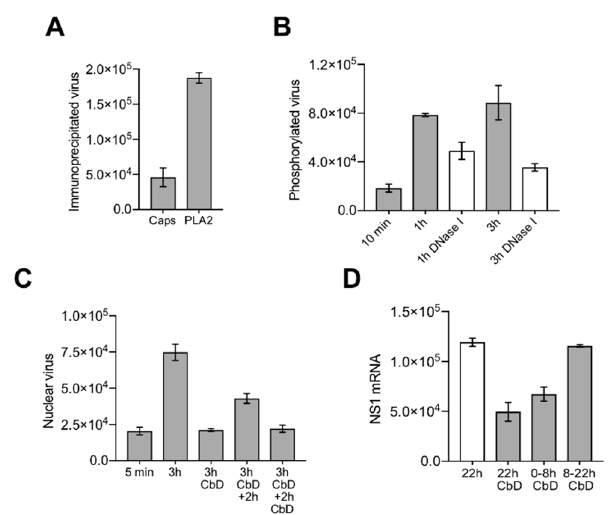
Figure 7. Inhibition of dynein-mediated nuclear targeting blocks the incoming viruses in the cytoplasm but does not prevent the capsid rearrangement, phosphorylation and uncoating ( A ) E ff ect of the dynein inhibitor ciliobrevin D (CbD; 100 µ M) on conformational epitope integrity (Caps / PLA2 ratio). ( B ) E ff ect of CbD on phosphorylation and DNA externalization. ( C ) E ff ect of CbD on the nuclear accumulation of B19V DNA. After 5 min (background control) and 3 h pi, cells were washed and the amount of viral DNA was quantified by qPCR. Additionally, cells were incubated for two additional hours in the presence or absence of CbD. All values of qPCR correspond to geq / µ L. ( D ) E ff ect of CbD on B19V infection. Cells were infected in the presence of CbD for the indicated times and the amount of NS1 mRNA was quantified by RT-qPCR at 22 h pi. Values represent NS1 mRNA copies/µL.